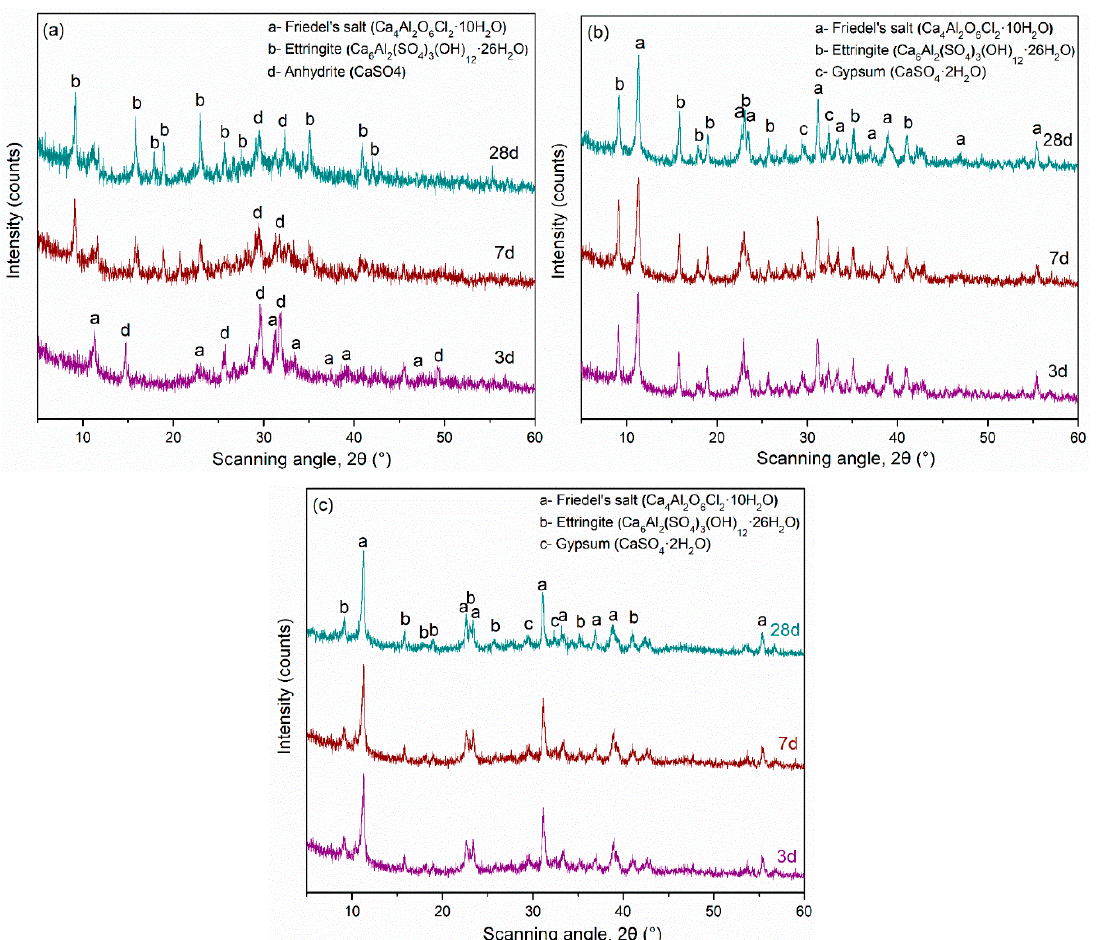
Figure 5. XRD patterns for pastes hydrated for 3, 7, and 28 days ( a ) L0, ( b ) L40/G10, and ( c ) G2 pastes.